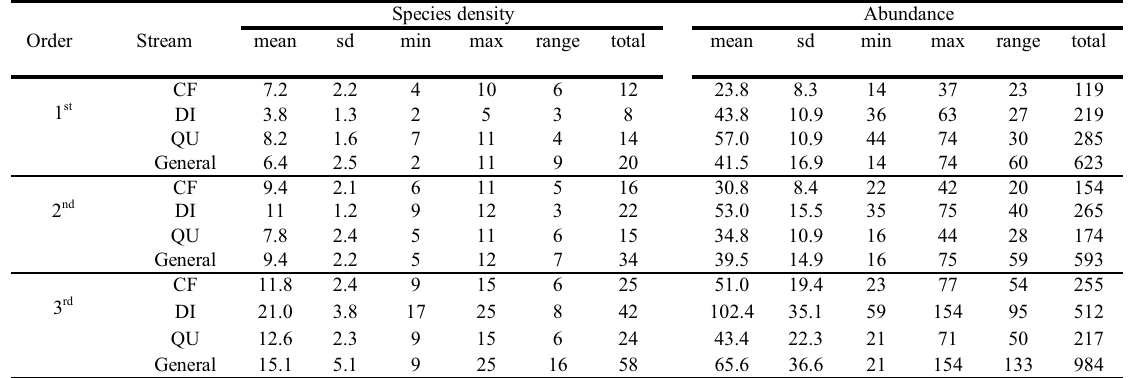
Table 2. Fish abundance and species density in 20-m reaches of 1 st , 2 nd , and 3 rd order streams segments located in the study areas of Biological Dynamics of Forest Fragments Project, Manaus, Amazonas State. Total= pooled values for five 20-m stream reaches. General= mean values by stream order.